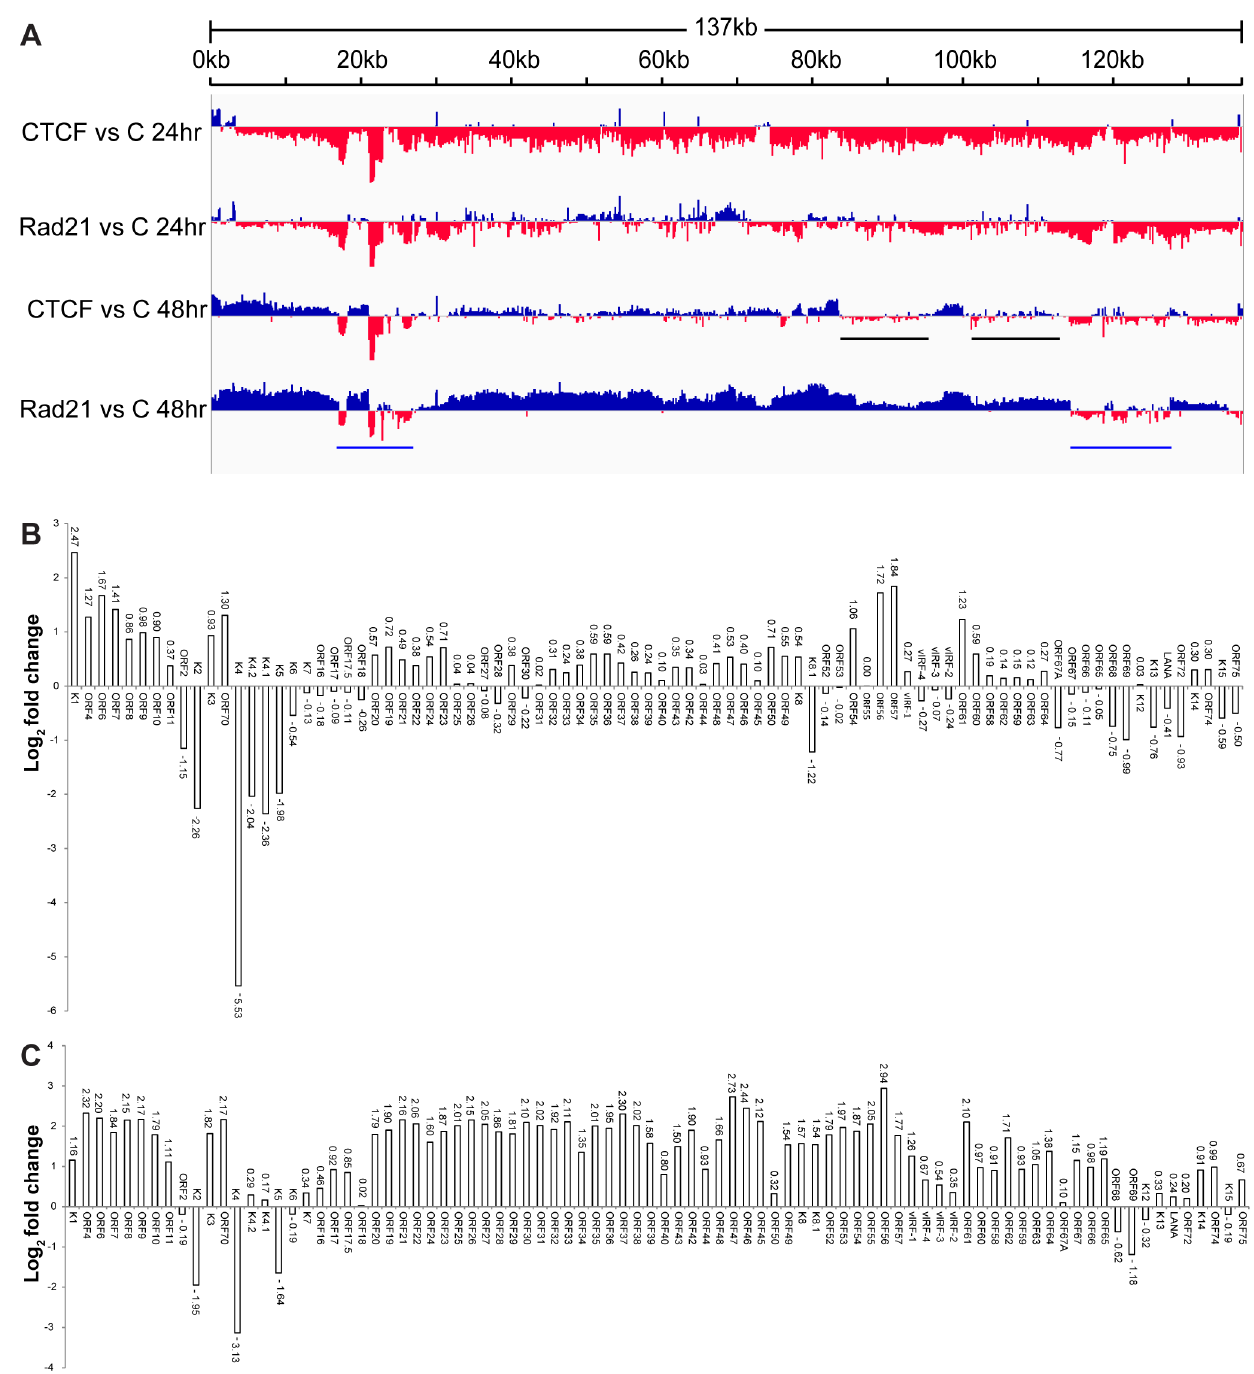
Figure 6. Effect of CTCF and Rad21 depletion on the KSHV lytic gene transcriptional profile defined by RNA-Seq. A. Transcriptome of iSLK cells at 24 h and 48 h after induction of lytic replication. iSLK cells were depleted of either CTCF or Rad21 with siRNAs or transfected with negative control siRNA. All cells were then induced to permit lytic KSHV replication by treatment with doxycycline. RNA was harvested at 24 h and 48 h from each sample and RNA sequencing was performed. The log ratios of read number for each position on the KSHV genome in cells depleted of either CTCF or Rad21 versus the values for corresponding control cells (C) are shown on the y-axis and the KSHV genome position on the x axis. Sites where CTCF or Rad21 knockdown leads to increased transcription compared to control are represented above the x-axis in blue. Regions where CTCF or Rad21 knockdown leads to decreased transcription compared to control are shown below the x-axis in red. Black bars show gene groups where the effects of CTCF and Rad21 differ and blue bars show genes that are CTCF and Rad21 dependent rather than repressed (see text). B. Effect of CTCF depletion on KSHV mRNAs. The effect of CTCF depletion on each annotated KSHV transcript is depicted as the log 2 ratio of its RNA abundance in the absence versus presence of CTCF at 48 h after induction. Transcripts whose levels increase with CTCF knockdown are thus shown above the x-axis and transcripts that decrease in abundance with CTCF knockdown are shown below. C. Effect of Rad21 depletion on KSHV mRNAs. The effect of Rad21 depletion on each annotated KSHV transcript is depicted as the log 2 ratio of its RNA abundance in the absence versus presence of Rad21 at 48 h after induction as described in panel (B) above. doi:10.1371/journal.ppat.1003880.g006 PLOS Pathogens |